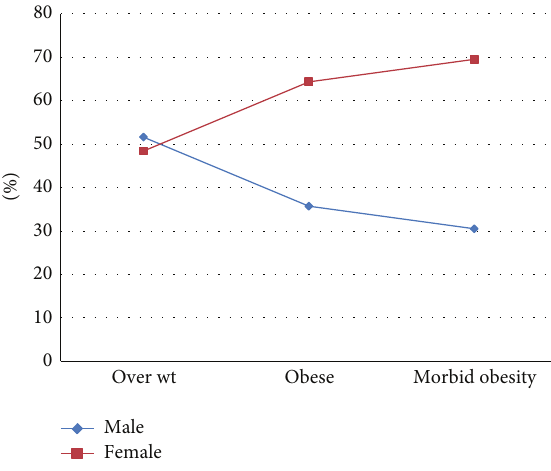
Figure 1: Description of BMI categories by